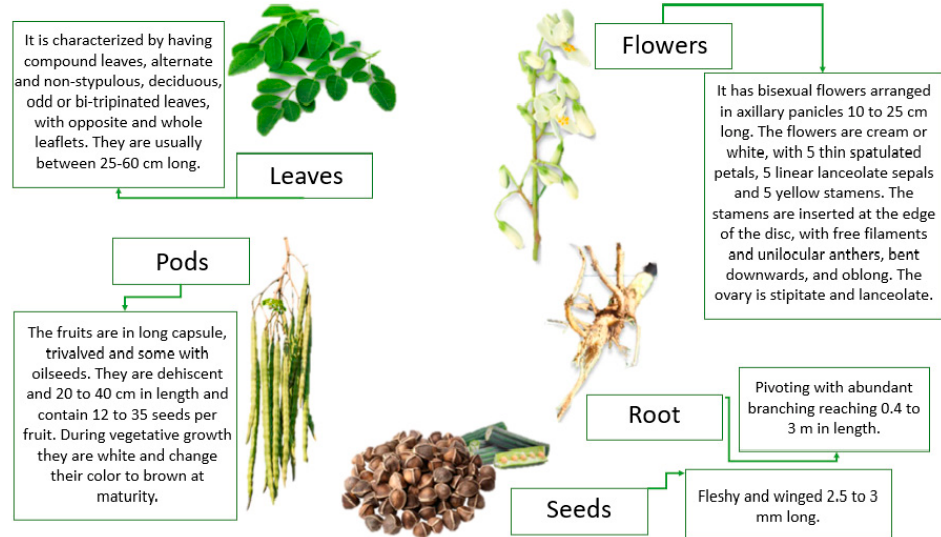
Figure 1. Parts of the plant and its main characteristics. (Sources: